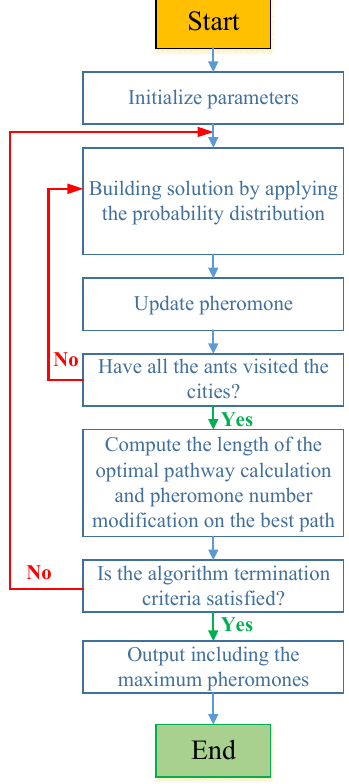
Figure 8. Structure of ant colony (ACO) optimization algorithm [46].